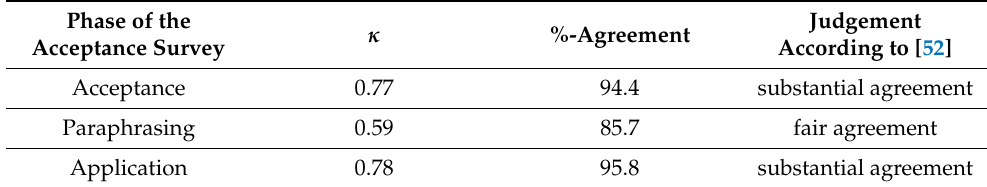
Table 3. Intercoder reliability for the different phases of our acceptance survey. Based on our coding manual, the accepted standards according to [52] were met.